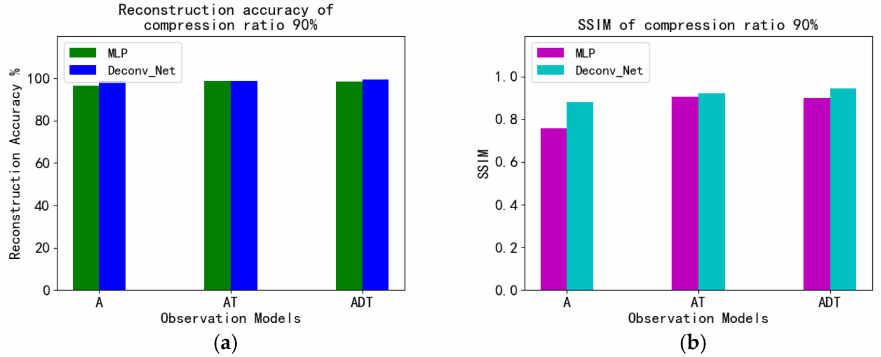
Figure 9. Comparison of reconstruction accuracy ( a ) and SSIM ( b ) between MLP and Deconv at a 90% compression